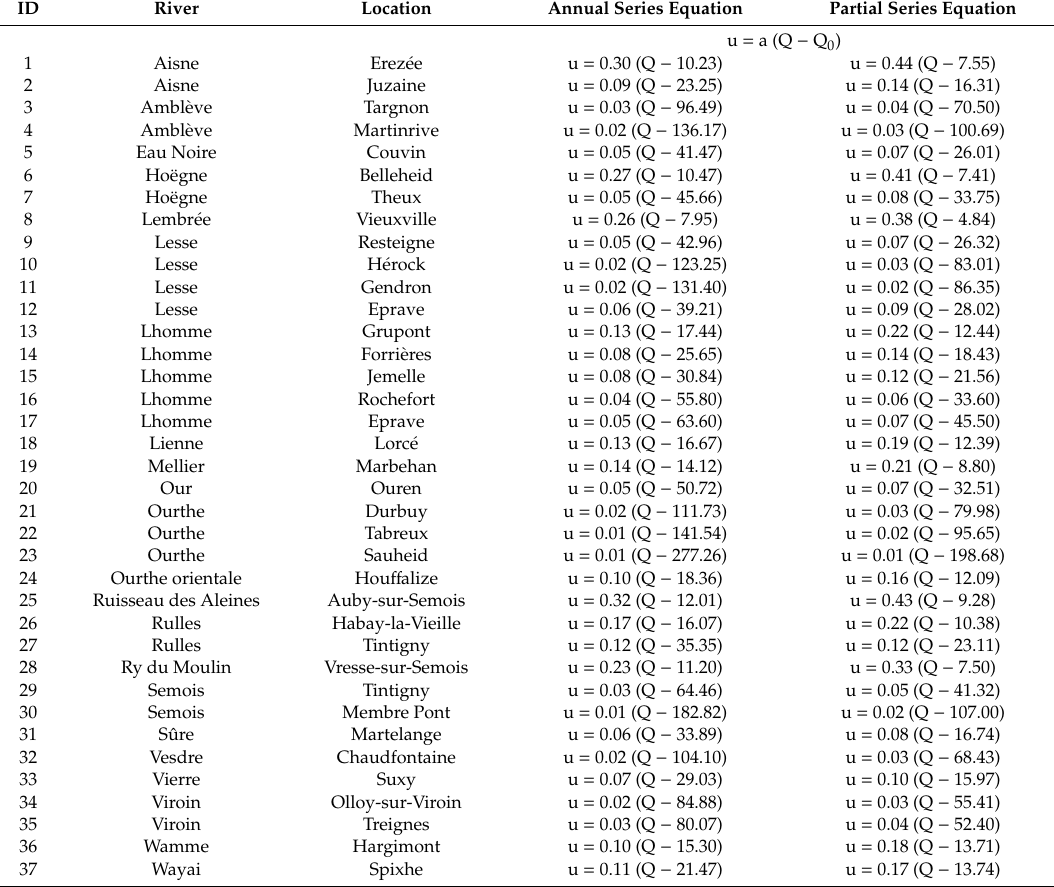
Table A2. Annual series and partial series equations (ordinary moments method of